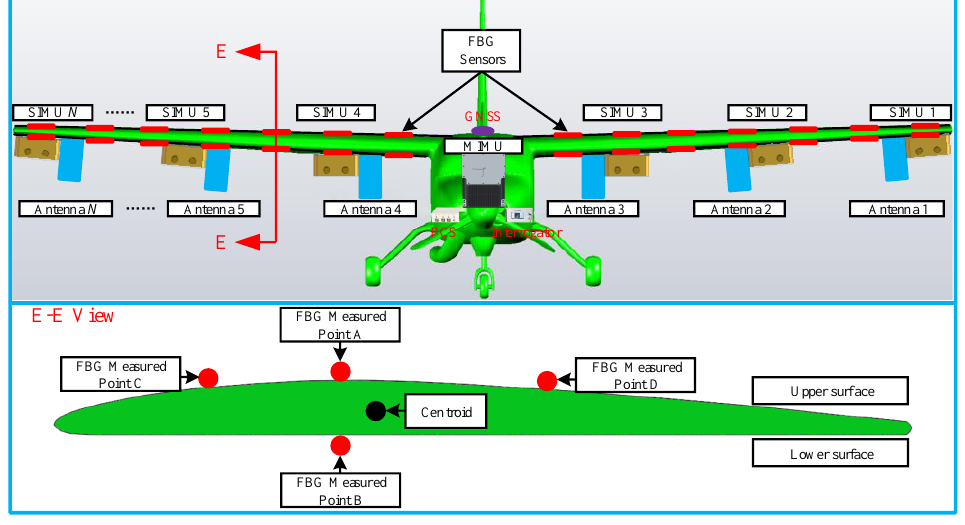
Figure 3. Layout of array POS.